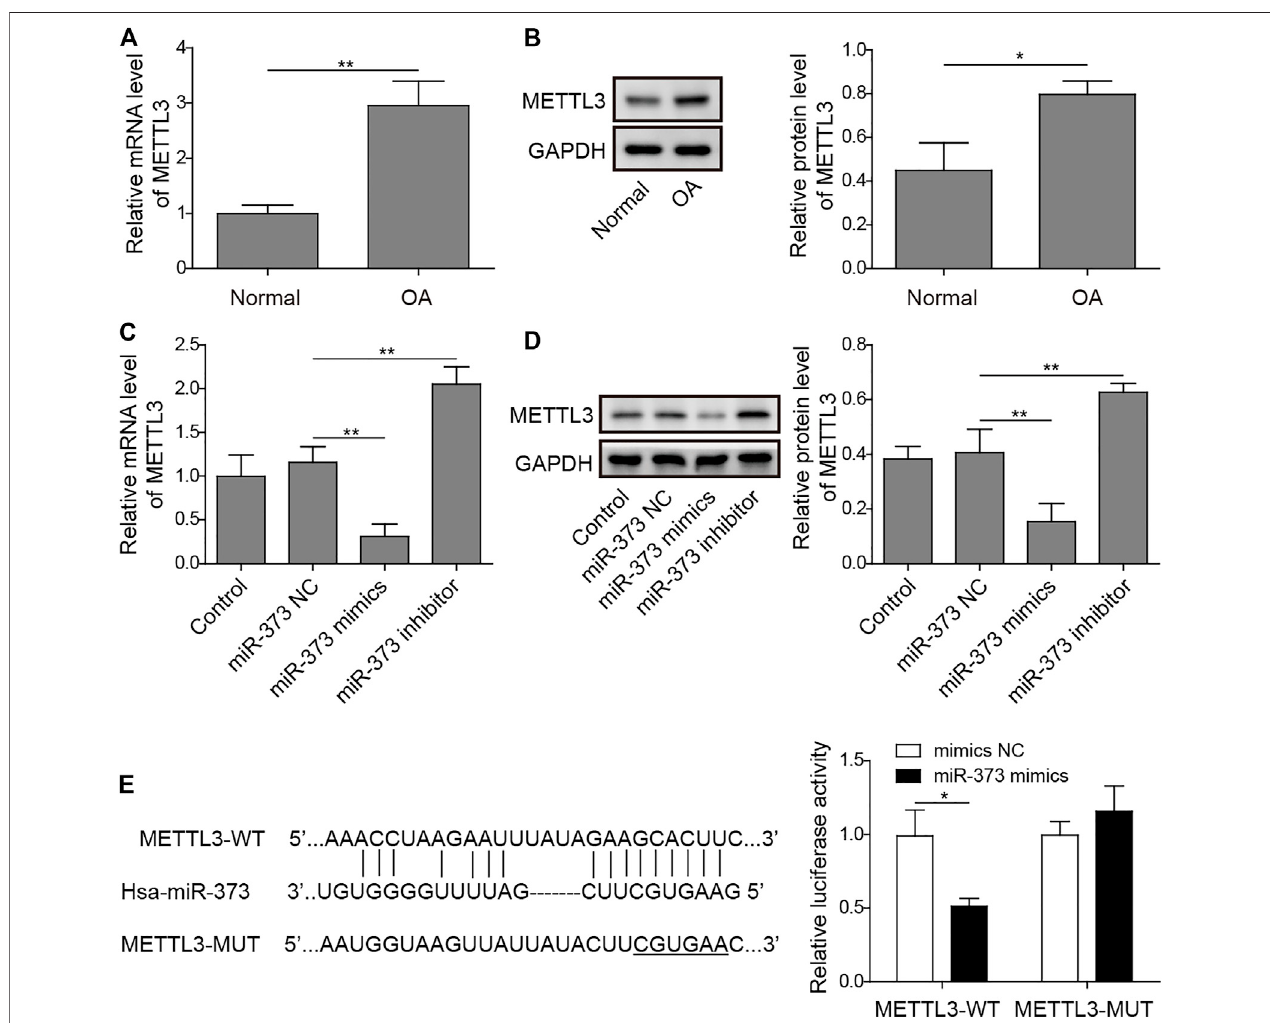
FIGURE4| METTL3wasadirecttarget ofmiR-373. (A,B) Theexpression ofMETTL3mRNAandprotein innormaland OAsampleswasdeterminedbyqRT-PCR and Western blotting. GAPDH was used as the endogenous reference for normalization. (C,D) The effect of miR-373 mimic or inhibitor on the expression of METTL3 mRNA and protein in cultured human chondrocytes was determined by qPCR and Western blotting. GAPDH was used as the endogenous reference for normalization. (E) The targeting speci fi city of miR-373 to METTL3 was veri fi ed by dual-luciferase reporter assay. A miR-373-resistant METTL3 was generated as the shown sequence.LuciferaseactivitybasedoneitherMETTL3-WTorMETTL3-MUTwasnormalizedtothecorrespondingmimicNCcontrolseparately. p < 0.05wasmarkedas *, p < 0.01 was marked as **.